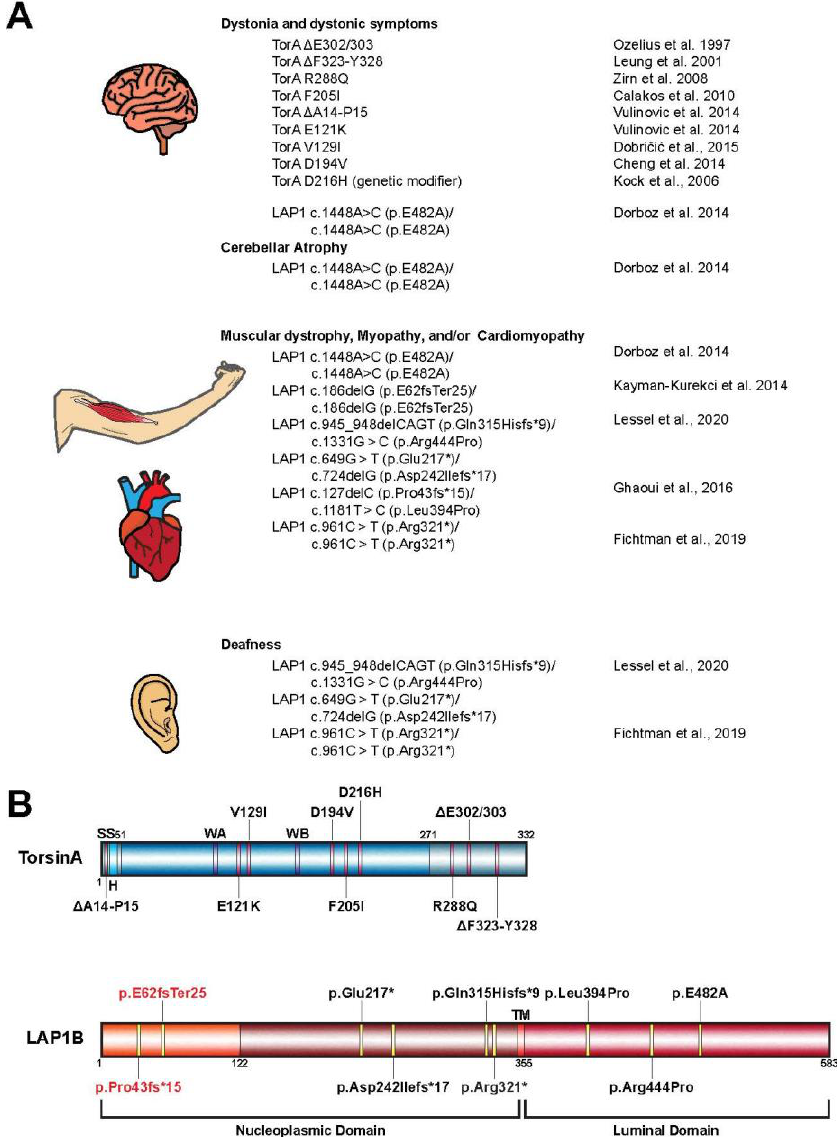
Figure 2 . ( A ) Mutations in TOR1A and TOR1AIP1 contribute to a variety of human disease pathologies. Shown is a comprehensive list of disease-associated mutations in the TOR1A (TorsinA) and TOR1AIP1 (lamina-associated polypeptide 1 or LAP1) genes. (B ) Schematic representation of TorsinA and the LAP1 isoform LAP1B highlighting the alteration associated with the mutations from panel A. LAP1C is a shorter isoform of LAP1 that results from an alternative translation initiation site that ultimately leads to the absence of residues 1–121 [17]. All alterations, except for p.E62fsTer25 and p.Pro43fs*15 (red), are present in both isoforms. SS, signal sequence; H, hydrophobic region; WA, Walker A motif; WB, Walker B motif; TM, transmembrane helix.